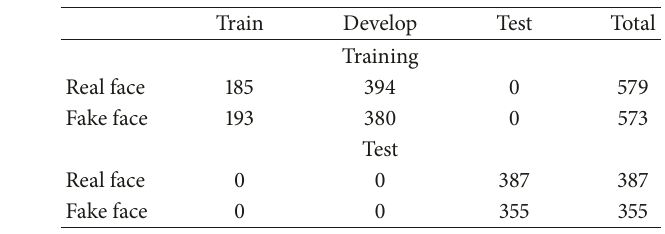
Table 2: Number of pictures on the PRINT dataset.